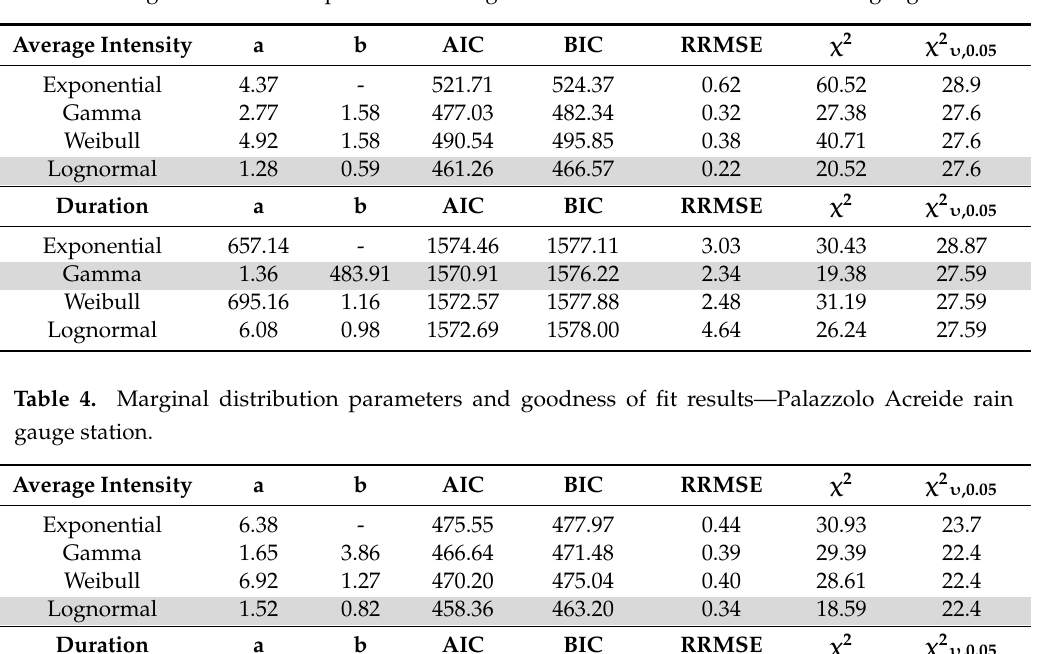
Table 3. Marginal distribution parameters and goodness of fit results—Monreale rain gauge station.